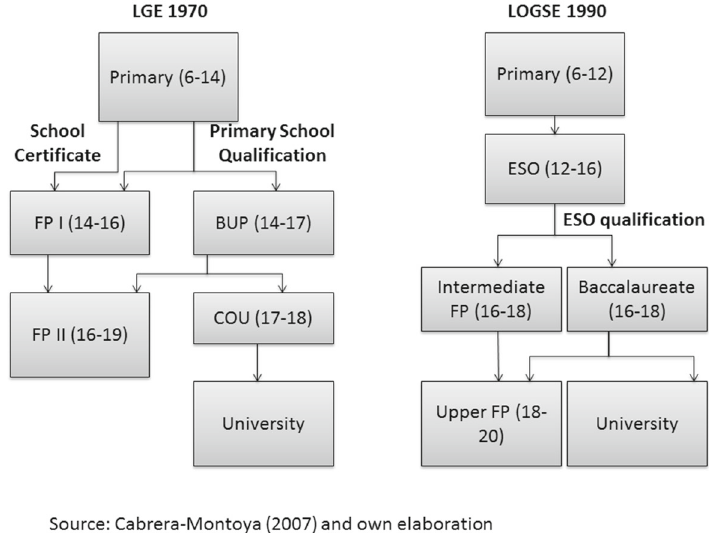
Fig. 1 Basic structure of the Spanish educational system under the LGE and the